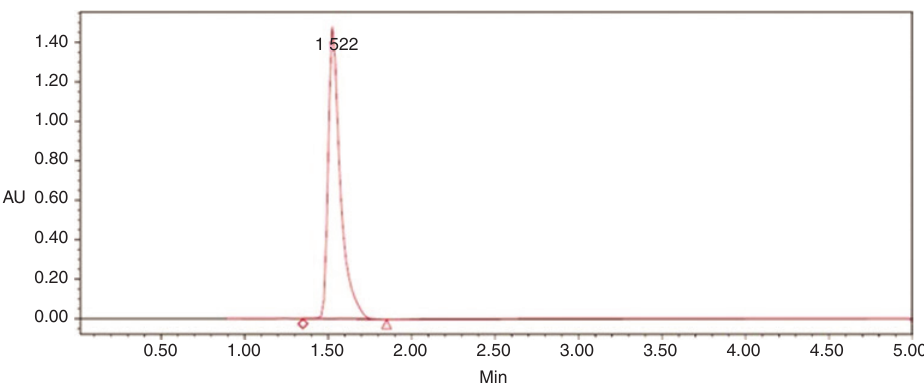
Figure 2: HPLC chromatogram of rosuvastatin in ethanol:methanol:ethyl acetate (6:3:1 v/v) with Rt of 1.52